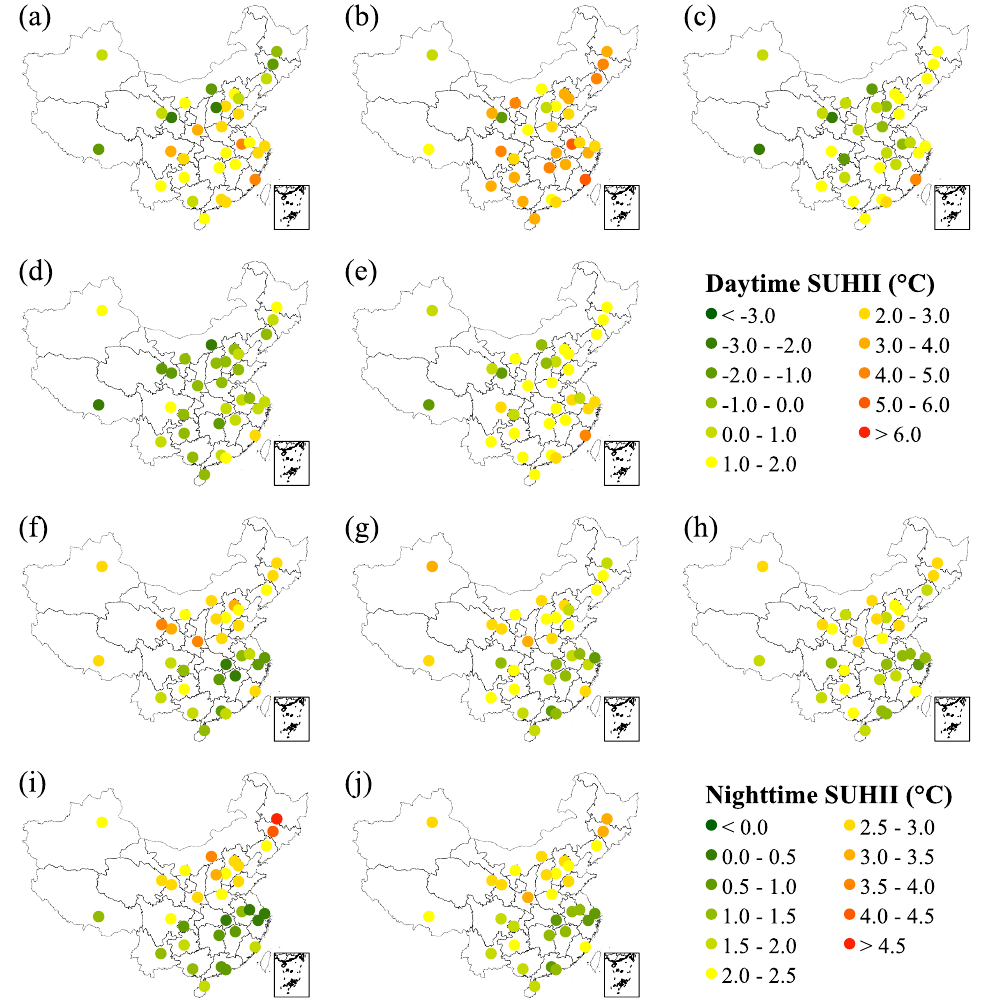
Figure 7. Maps showing the spatial pattern of the daytime SUHII in ( a ) spring, ( b ) summer, ( c ) autumn, ( d ) winter, and ( e ) annual, and the nighttime SUHII in ( f ) spring, ( g ) summer, ( h ) autumn, ( i ) winter, and ( j ) annual during the period January –December 2009 across China’s 32 major cities.